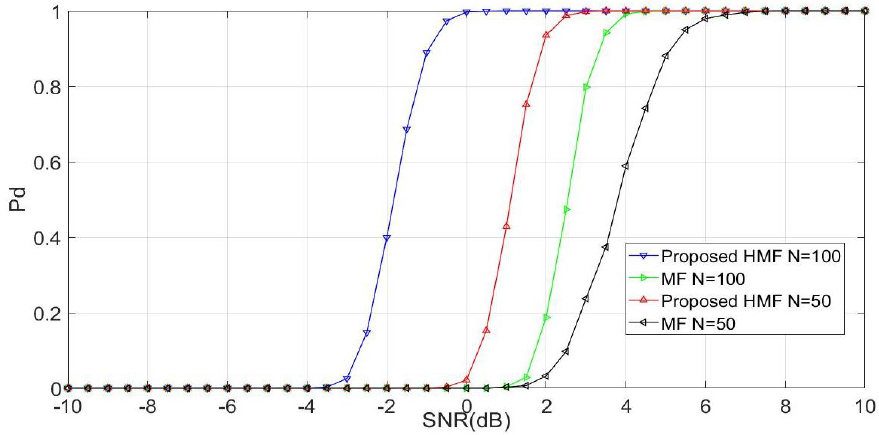
Figure 4. Performance of Pd and SNR for HMF and MF, considering number of samples = 50 and 100 in the Rayleigh Channel.